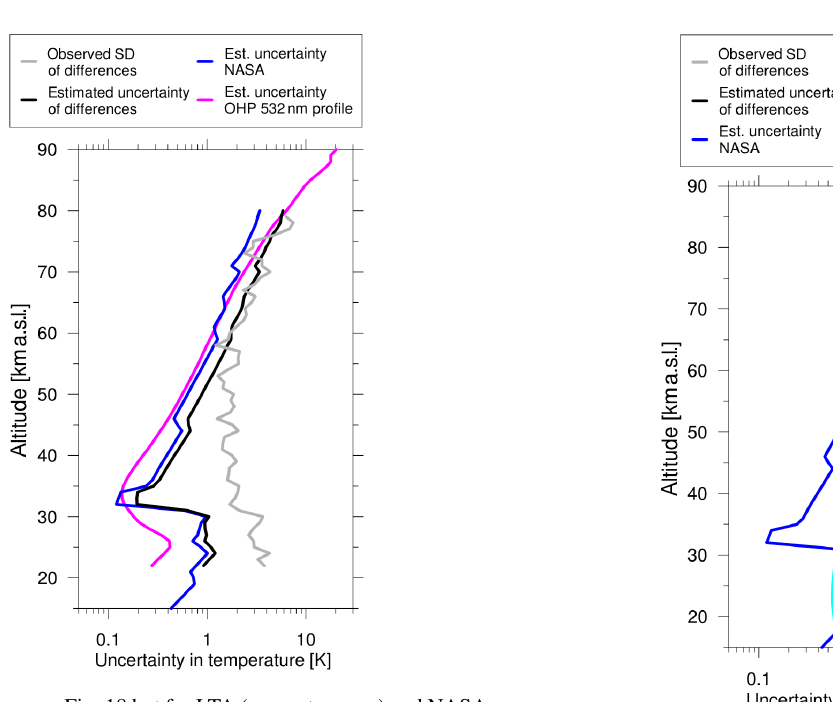
Figure 19. Same as Fig. 18 but for LTA (magenta curve) and NASA STROZ.